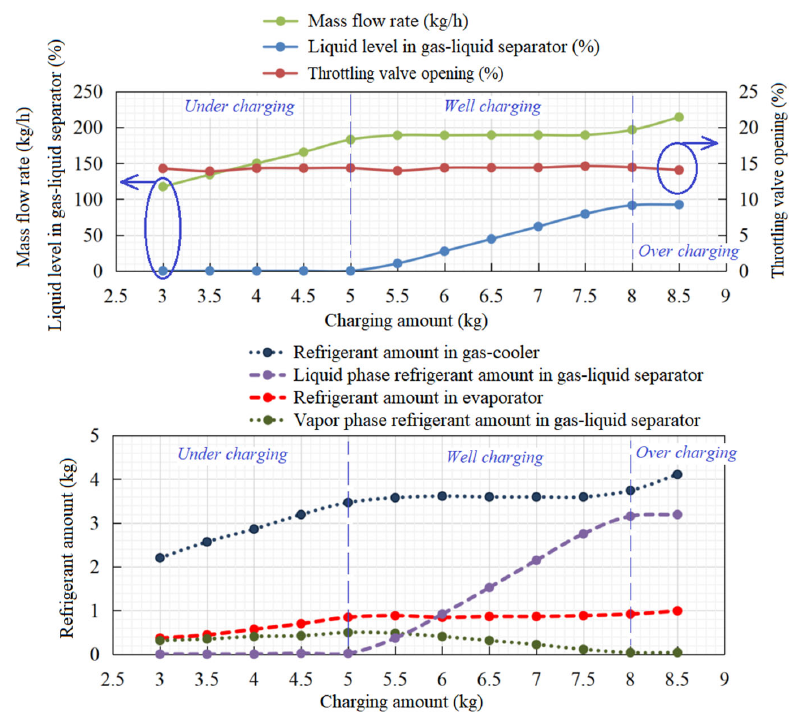
Figure 7. The CO 2 refrigerant distribution under various refrigerant charging